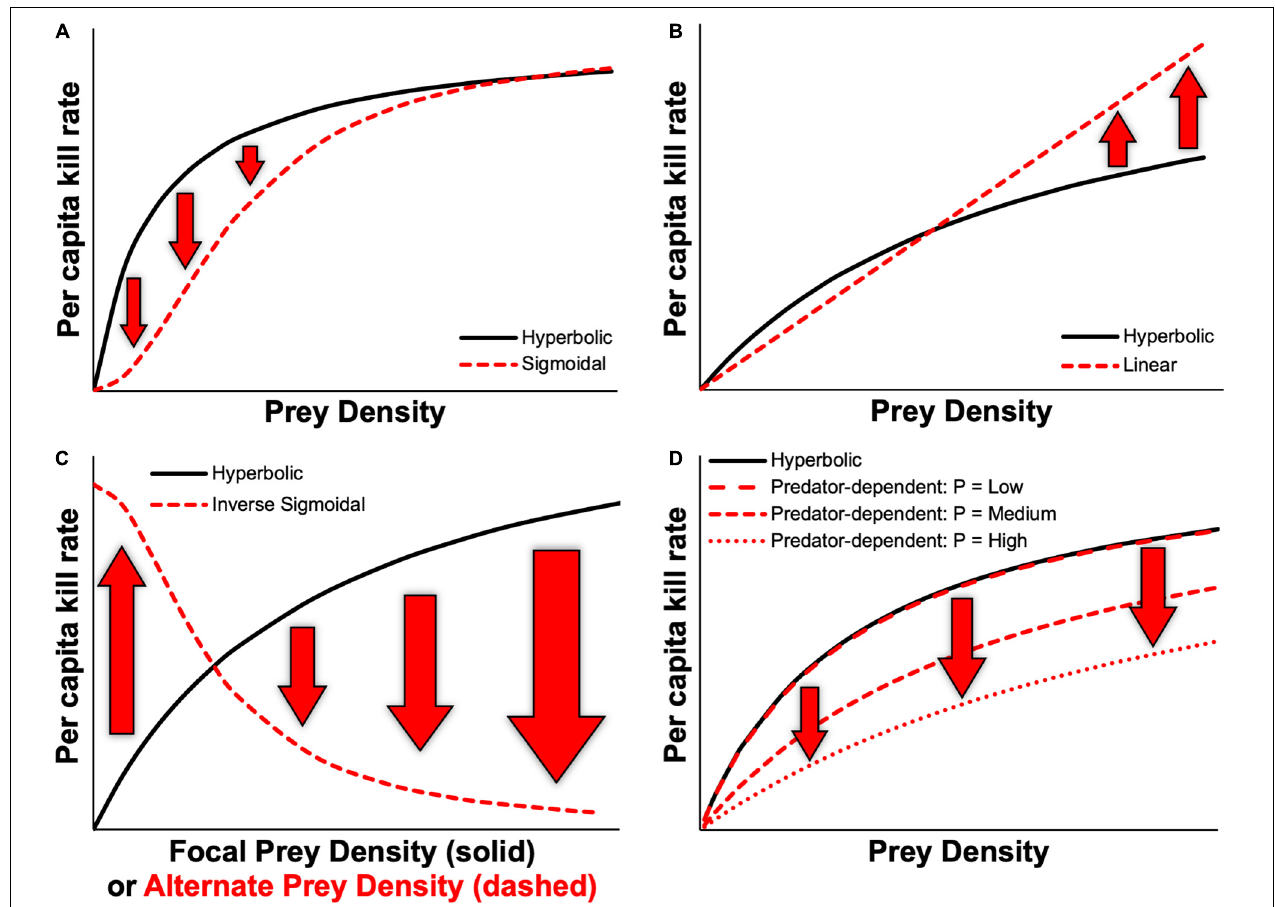
FIGURE 1 | Examples of various functional response relationships based on the Kluane vertebrate system, Yukon, Canada, highlighting potential differences in predicted kill rates between prey-dependent hyperbolic relationships and (A) prey-dependent sigmoidal, (B) prey-dependent linear, (C) inverse sigmoidal, and (D) predator-dependent functional responses, where P represents the predator